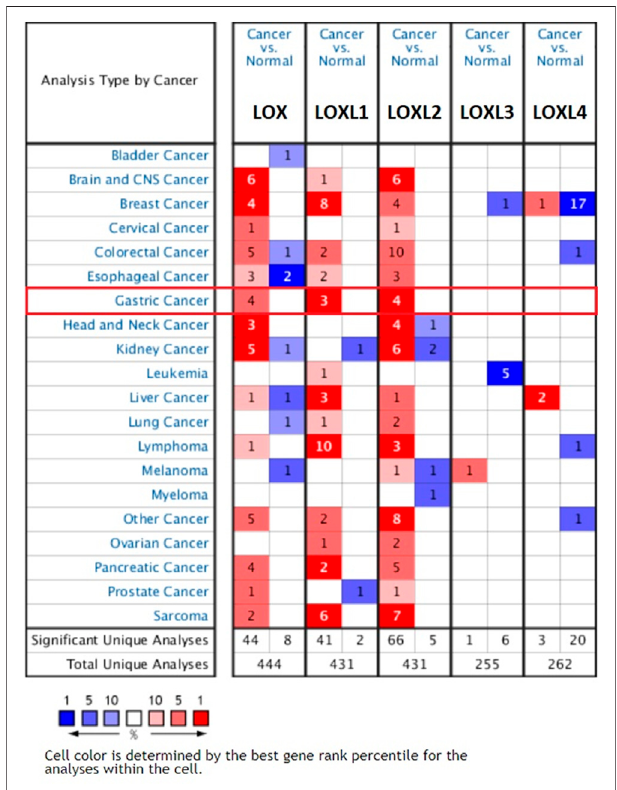
FIGURE 1 | Transcription levels of LOX family in different cancer types